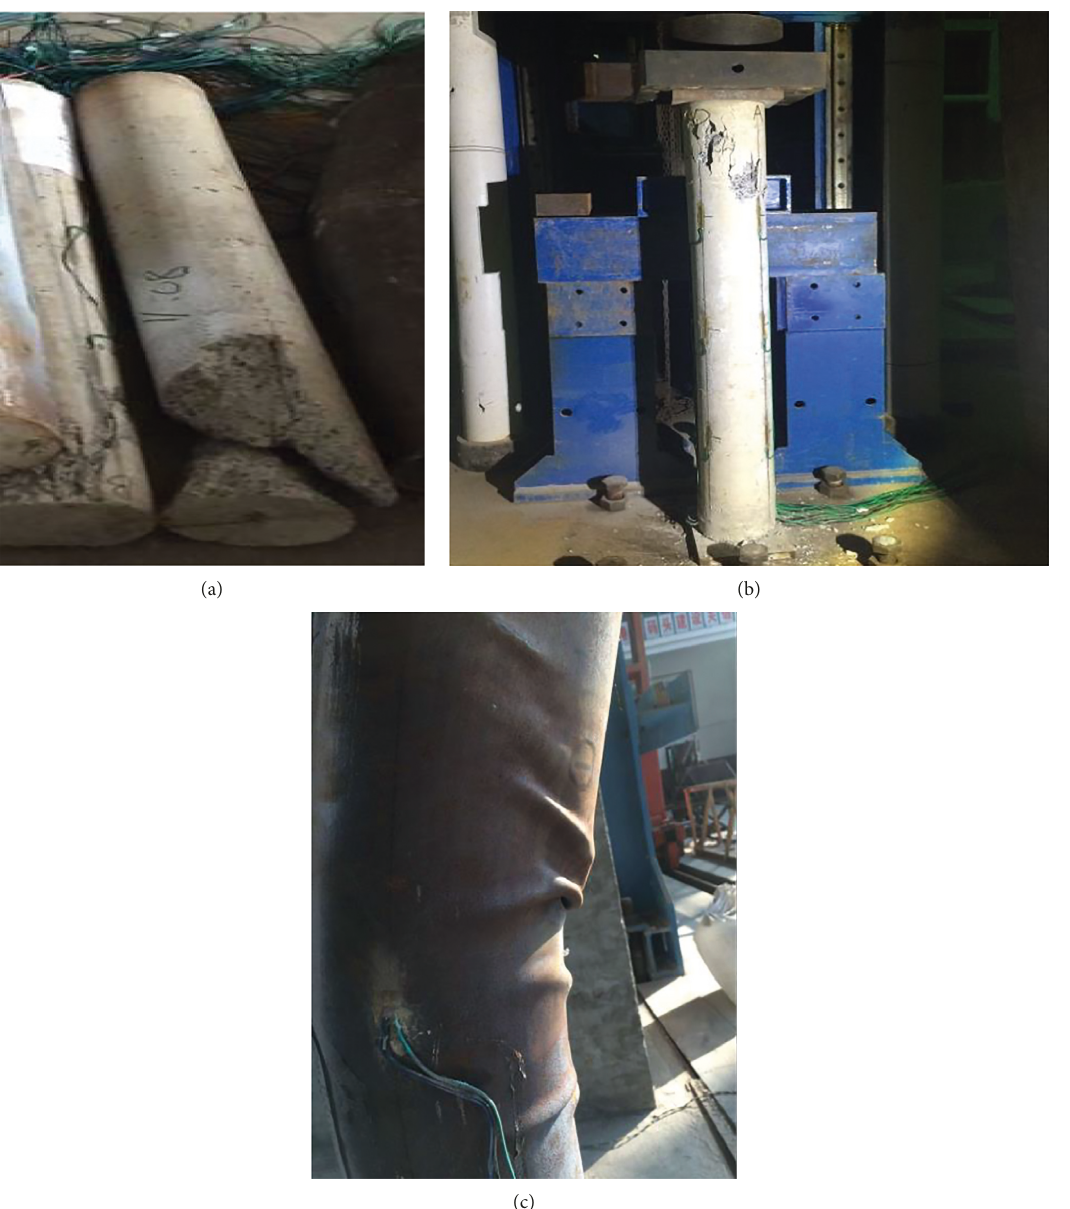
Figure 5: Failure modes. (a) Plain concrete pile. (b) Reinforced concrete pile. (c) Unreinforced CFST